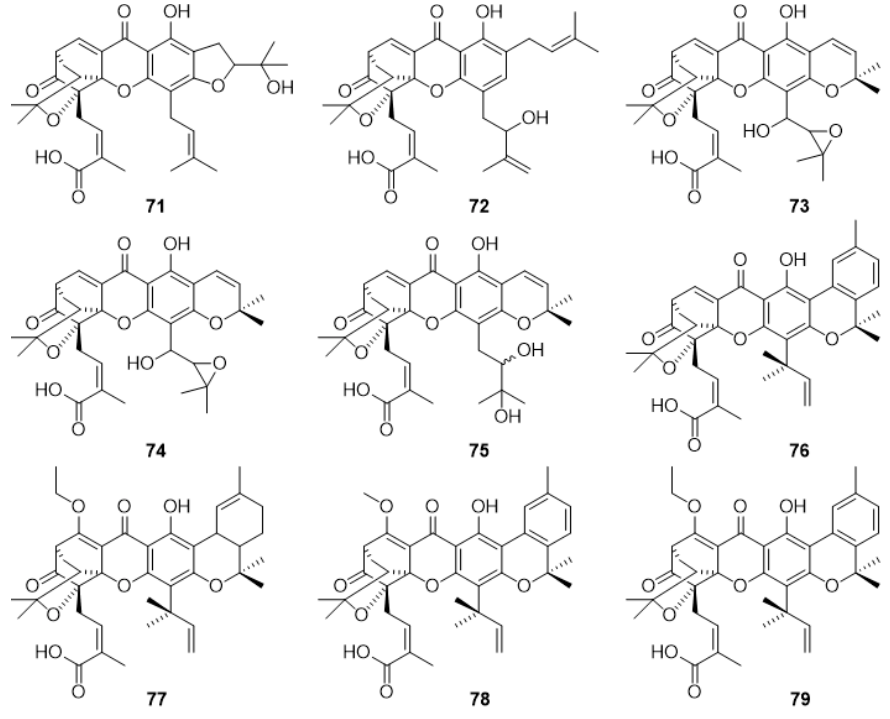
Figure 5. Structures of gaudichaudiic acid A–I ( 71 – 79 ).